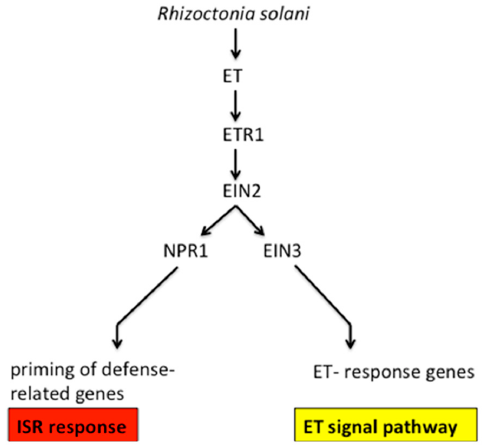
Figure 10. Proposed signal transduction pathways of the ISR and ET.